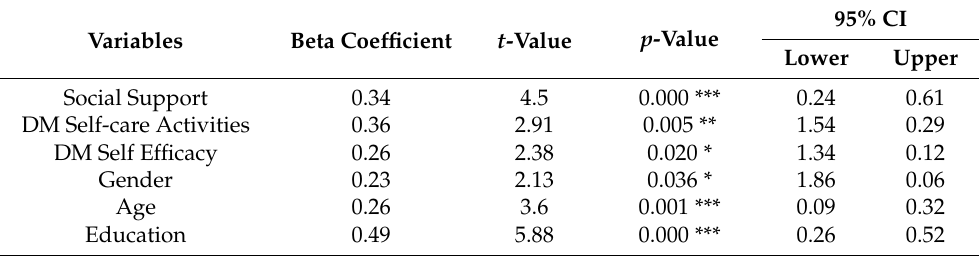
Table 3. Regression analysis of HbA1c control with social support, self-care activities, diabetes self-efficacy and selected patient characteristics.